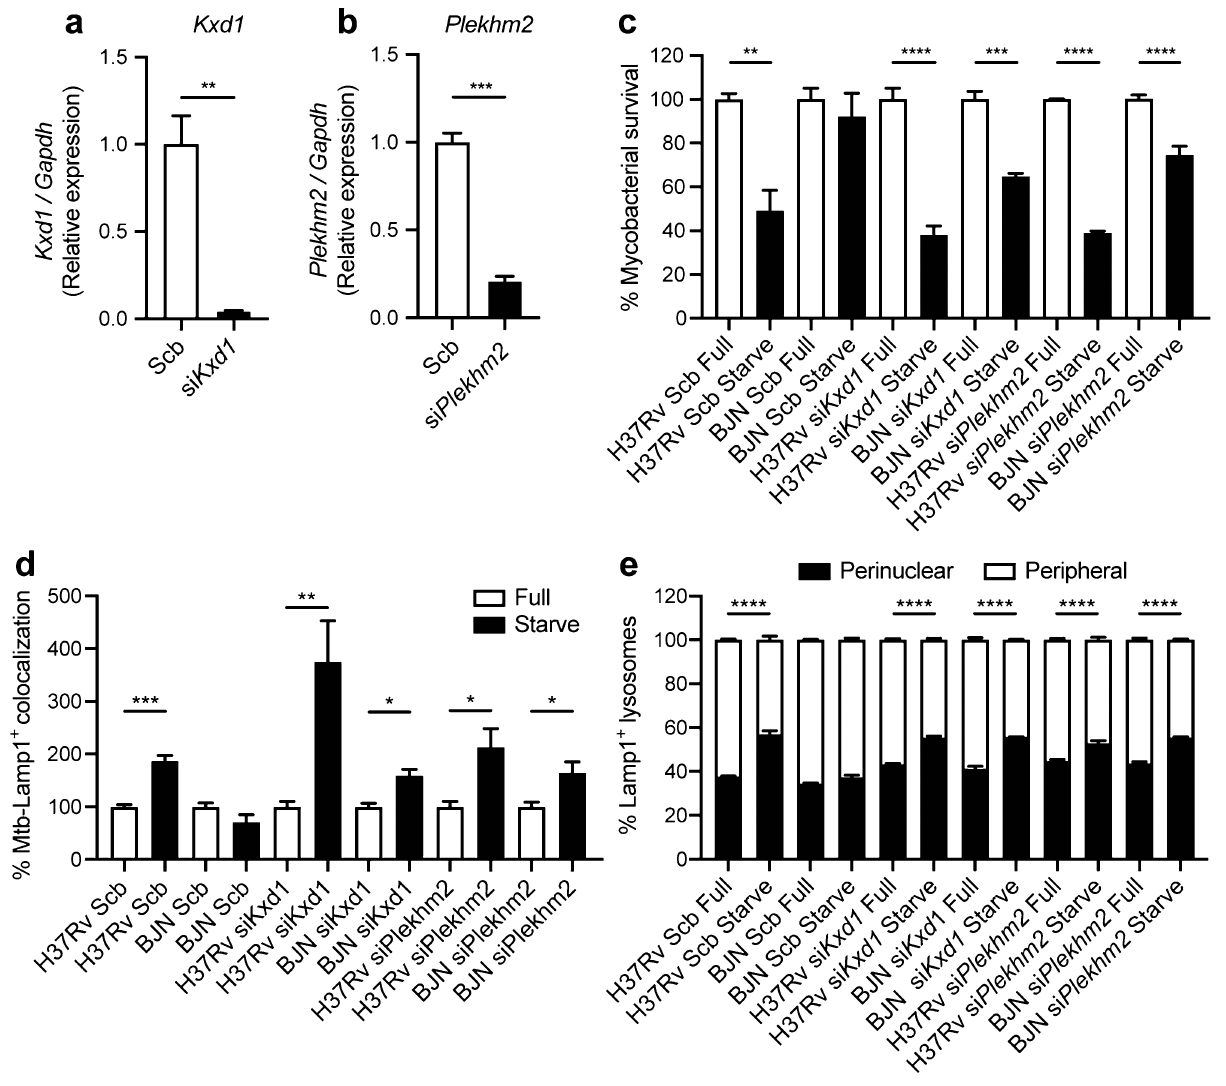
Figure 6. Kxd1 and Plekhm2 are required for suppression of lysosome redistribution towards the perinuclear region upon autophagy induction by starvation in BJN-infected BMDMs. ( a , b ) BMDMs were transfected with the control scrambled siRNAs or siRNAs targeting Kxd1 and Plekhm2 . At 48 h after transfection, Kxd1 and Pleckhm2 expression levels were determined by qRT-PCR. Data are means ± SEM from at least three independent experiments; **p < 0.01 and ***p < 0.001 were determined by two-tailed unpaired Student’s t-test. ( c ) Kxd1- and Pleckhm2-deficient BMDMs were infected with mCherry-expressing H37Rv or BJN for 1 h. Cells were then washed with PBS and subjected to autophagy induction by starvation for 4 h. Cells were fixed and the nucleus was stained with Hoechst. High-content image analysis was then conducted to determine the number of intracellular mycobacteria per cell. Percent mycobacterial survival was calculated and then compared. Data are means ± SEM from at least three independent experiments; **p < 0.01, ***p < 0.001 and ****p < 0.0001, all relative to the full control set of 100%, were determined by one-way ANOVA with Tukey’s multiple comparison test. ( d ) Kxd1- and Plekhm2-deficient BMDMs were infected with Alexa-546-labelled H37Rv or BJN at MOI of 10 for 15 min and chased for 1 h. Cells were then washed with PBS and subjected to autophagy induction by starvation for 2 h. Samples were then fixed and processed for staining with anti-Lamp1 antibody and Hoechst. Percent mycobacteria-Lamp1 colocalisation was then analysed by high-content image analysis. Data are means ± SEM from at least three independent experiments; *p < 0.05, **p < 0.001 and ***p < 0.0001, all relative to the full control set of 100% were determined by one-way ANOVA with Tukey’s multiple comparison test. ( e ) Kxd1- and Plekhm2-deficient BMDMs were infected with Alexa-546-labelled H37Rv or BJN at MOI of 10 for 15 min and chased for 1 h. Cells were then subjected to autophagy induction by starvation for 24 h and processed for staining with anti-Lamp1 antibody and Hoechst. High-content image analysis was then conducted to count the numbers of Lamp1 + lysosomes in each cytoplasmic subarea of the infected cells. Percent perinuclear Lamp1 + lysosomes and periphery Lamp1 + lysosomes were then calculated and compared as in Fig. 5. Data are means ± SEM from at least three independent experiments; ****p < 0.0001, relative to the full control was determined by one-way ANOVA with Tukey’s multiple comparison